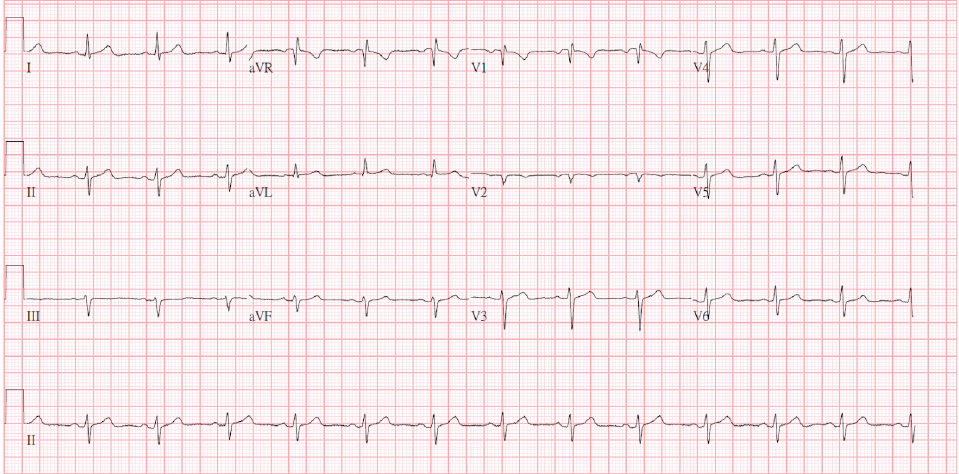
depression. The pathologic Q wave was not seen in our patient.